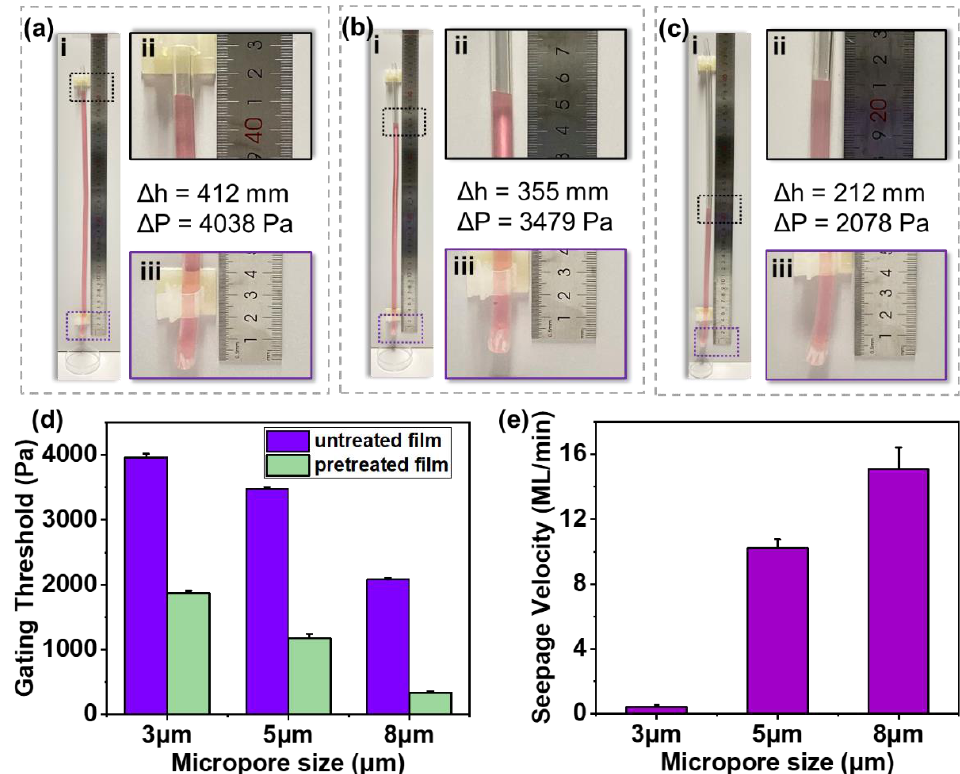
Figure 4. Retention and conducting performances of microporous membranes with the high gating threshold. ( a ) The retention performance of microporous membranes with the 3 µm pore size. ( b ) The retention performance of the microporous membrane with the 5 µm pore size. ( c ) The retention performance of the microporous membrane with the 8 µm pore size. ( d ) Gating thresholds of untreated and pretreated microporous membranes with different pore sizes. ( e ) Seepage velocity of pretreated microporous membranes with different pore sizes.